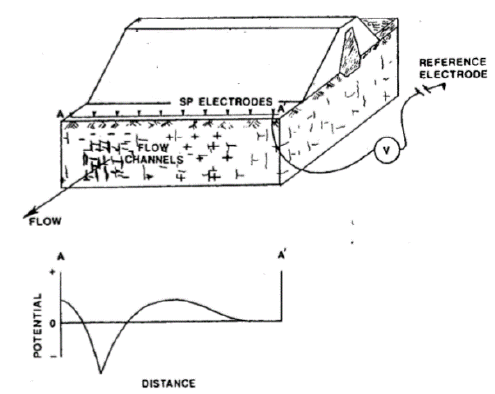
Figure 2: Illustration obtained for an electrode array set up on the surface of a dam and the SP anomaly generated by water underground leakage (https://www.kau.edu.sa/Files/0003035/Subjects/SP.pdf).